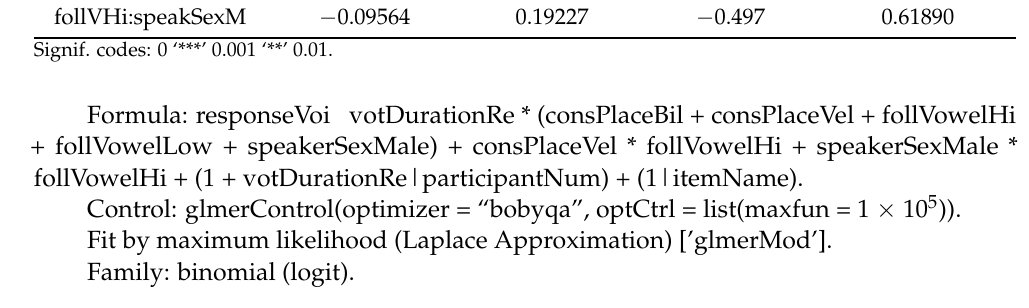
Table A4. Mean rates of ‘voiced’ responses (%) across 10 VOT levels (Experiment 2, original and resynthesized voice tokens). VOT